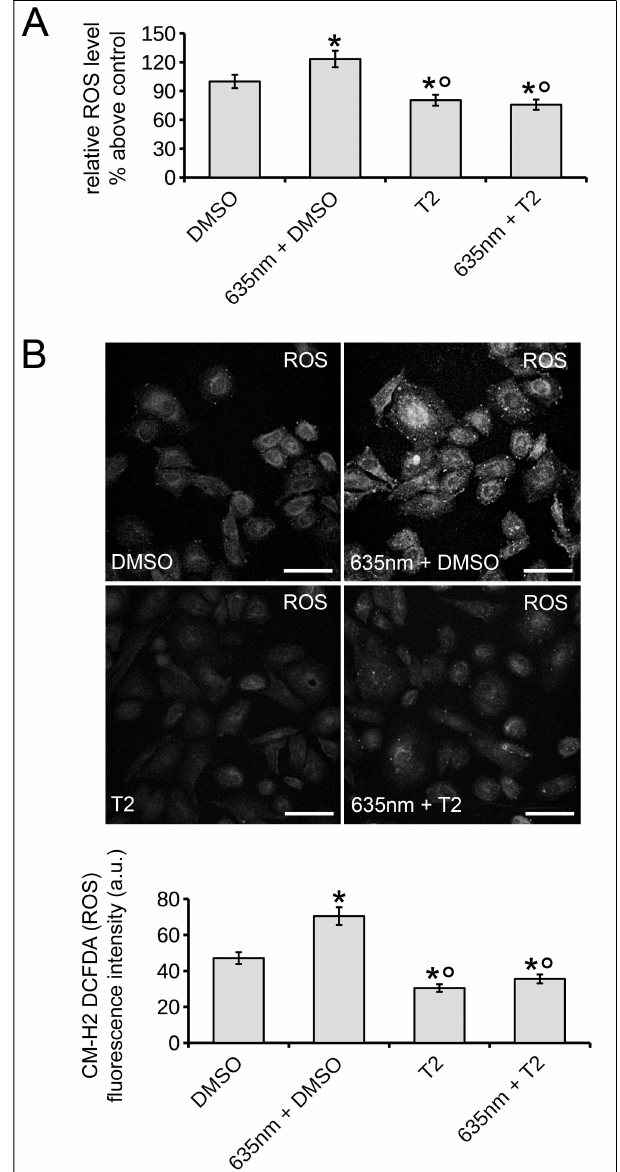
Figure 8. Effect of red PBM and Akt signaling inhibition on ROS production in osteoblasts. ROS generation was measured with CM-H 2 DCFDA in osteoblasts cultured in the absence (DMSO) or presence of the Akt inhibitor triciribine (2 µM, T2) subjected or not to PBM with 635 nm as reported in Table 1, 1 h after light delivery. ( A ) Fluorometric ROS detection. ( B ) Representative confocal fluorescence images of intracellular ROS. Scale bar: 50 µm. The histogram shows the densitometric analyses of the intensity of CM-H 2 DCFDA (ROS) green fluorescence signals performed on digitized images. The data are representative of at least three independent experiments, performed in triplicate. The values are expressed as mean ± S.E.M. Significance of difference: * p < 0.05 vs. DMSO, ° p < 0.05 vs. 635 nm + DMSO.